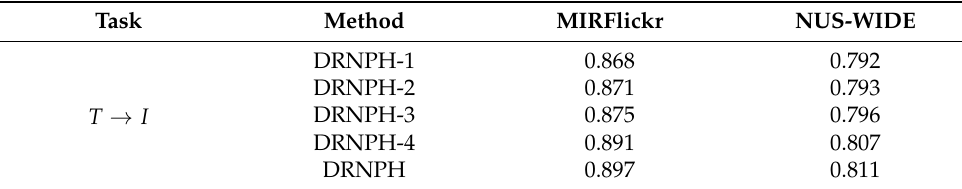
Table 5. The mAP@50 of the text retrieving image task and the number of binary bits is 128.